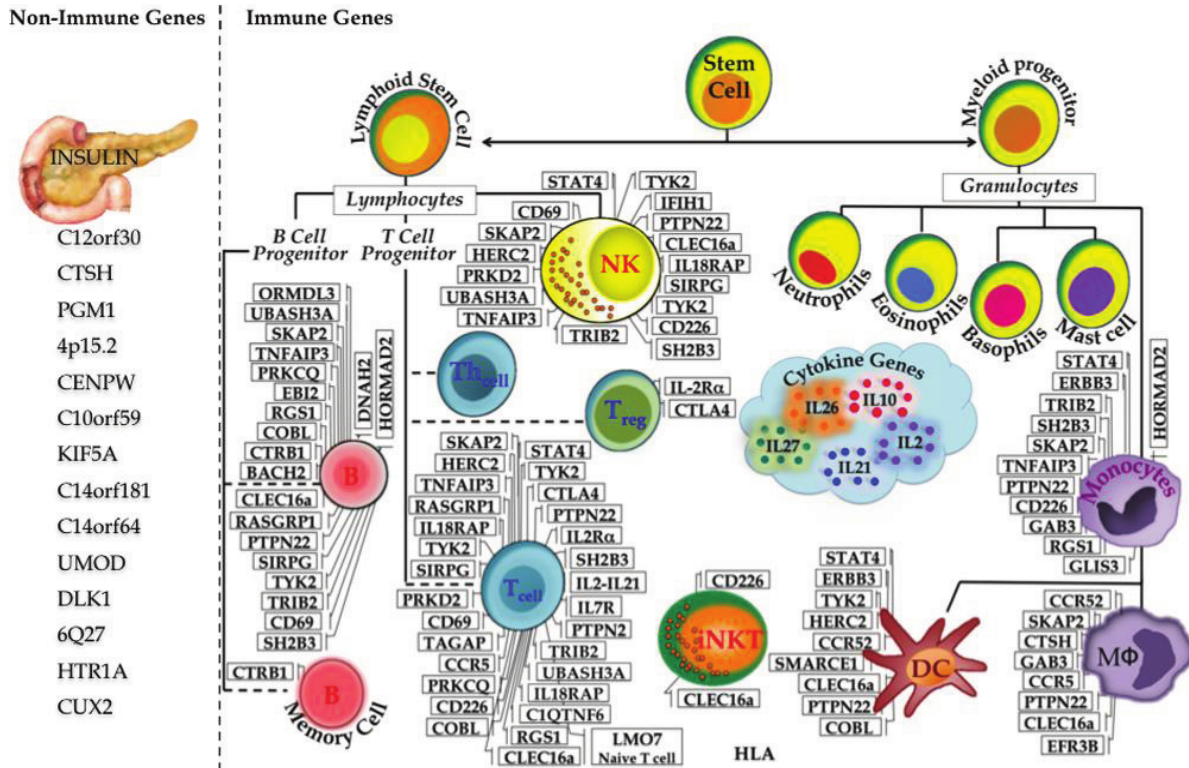
Figure 2. Immune and Non-immune T1D genes. The discovery of T1D susceptibility genes started as early as 1974, with six T1D genes identified by 2006. The advent of GWAS led to flurry of novel genes associated with T1D reaching the excess of 40 by 2009 and almost 60 by